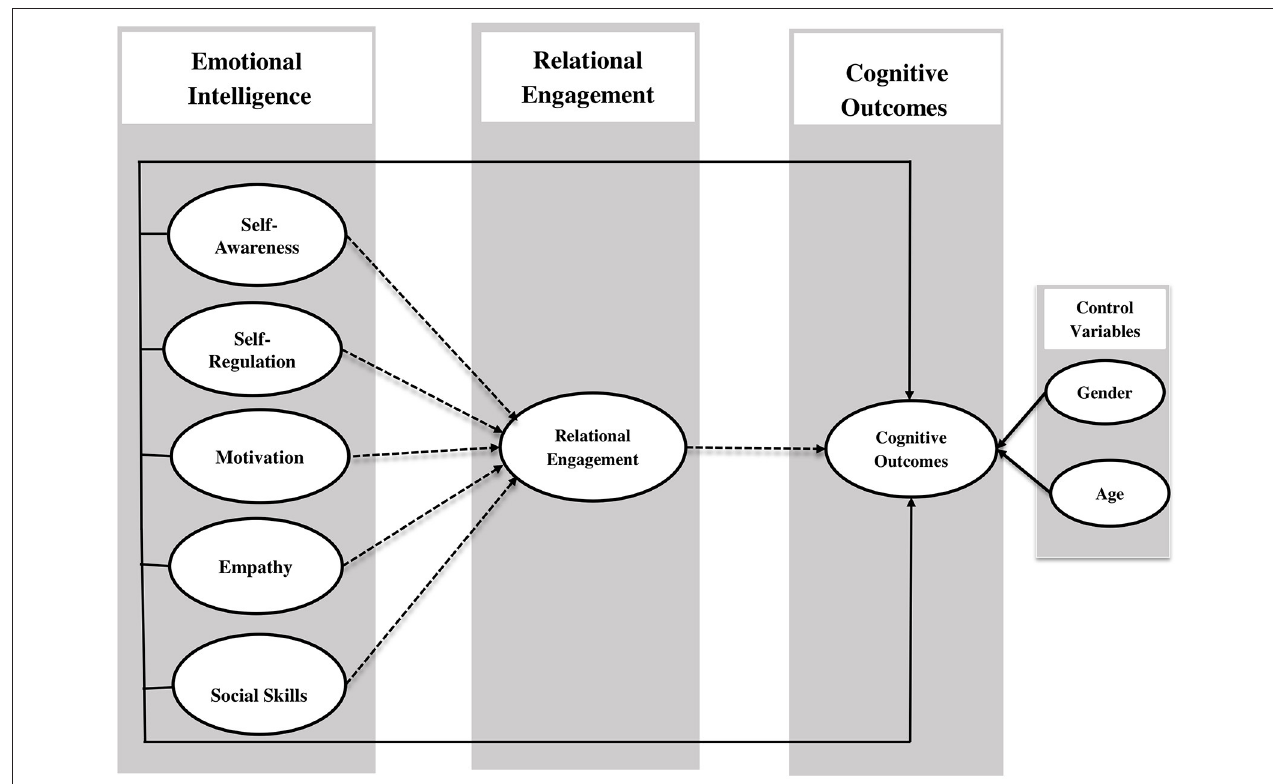
FIGURE 1 | Theoretical